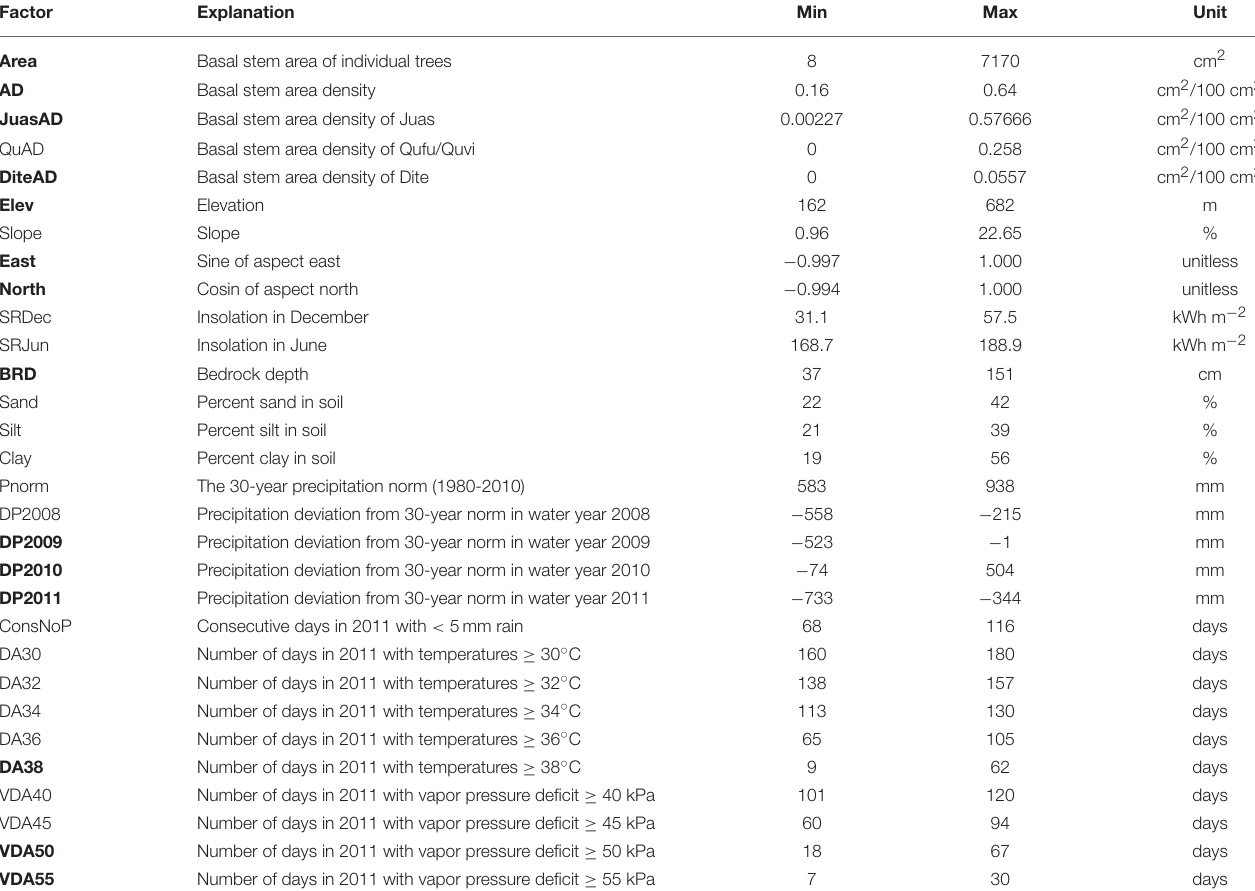
TABLE 2 | List of all risk factors considered in the regression models, with data ranges and units. Factor